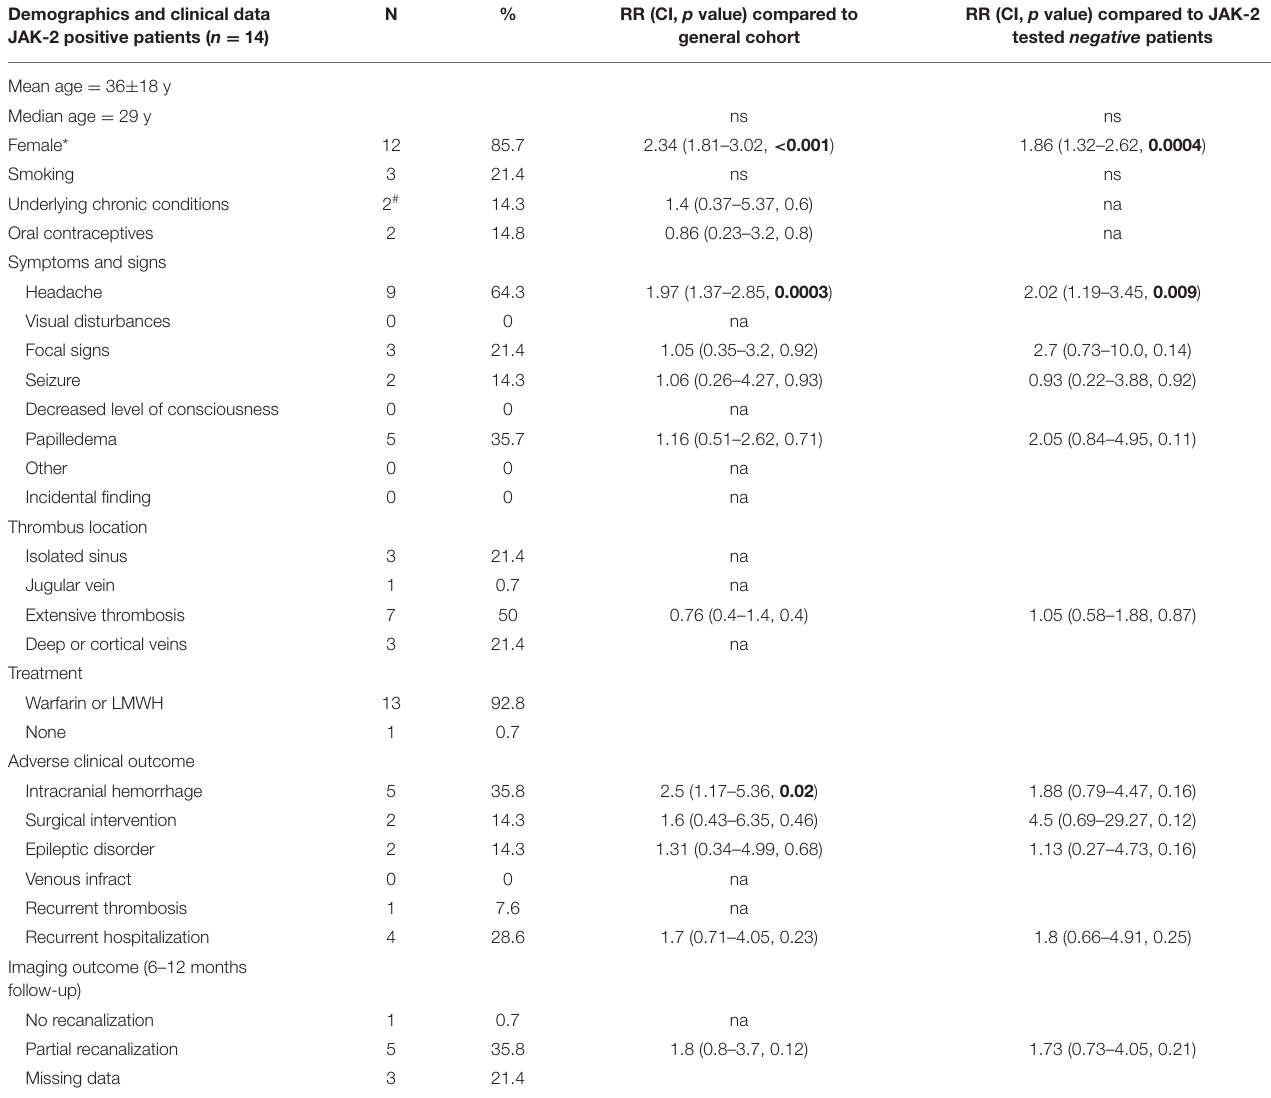
N % RR (CI, p value) compared to